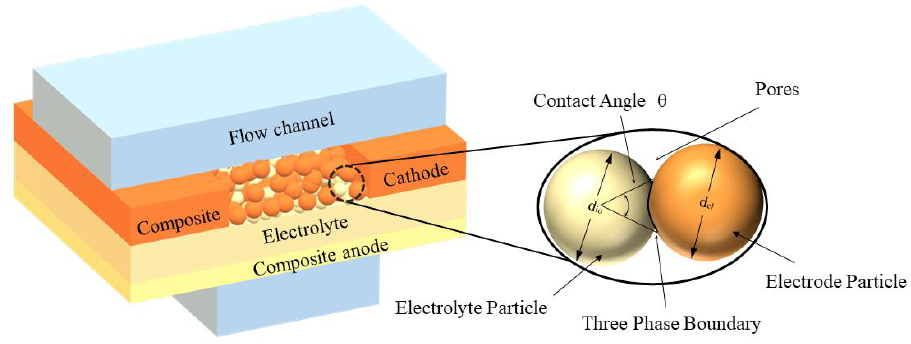
Figure 2. Schematic diagram of the mesoscopic structure of the composite electrode applied to the SOEC unit.